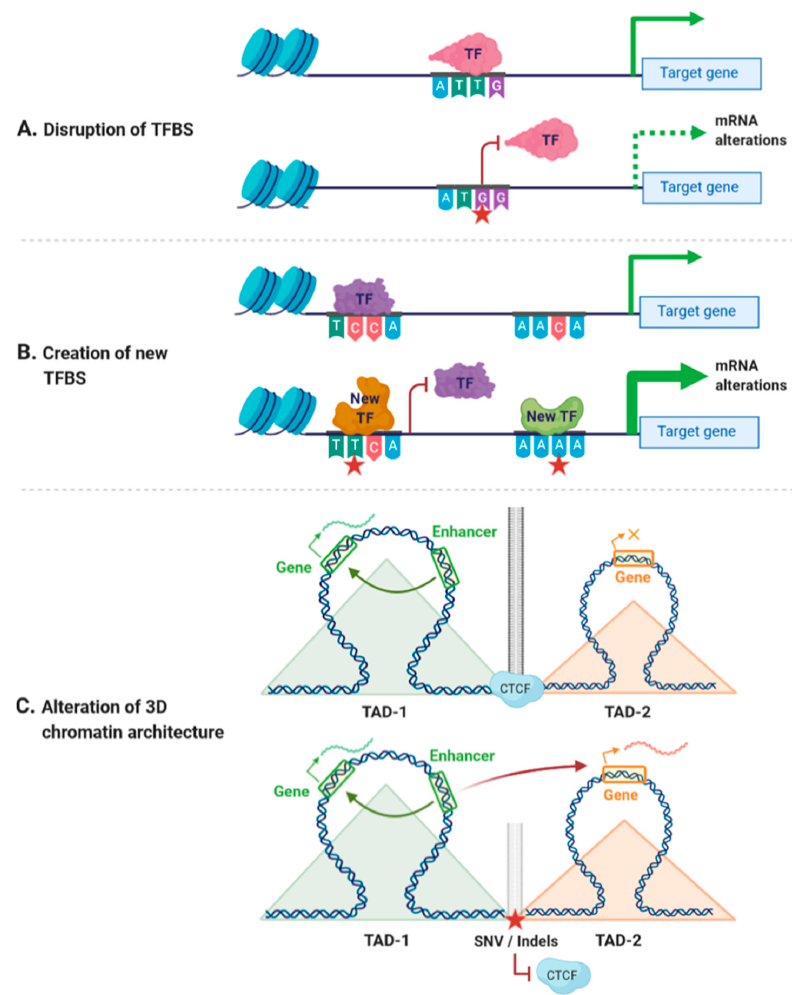
Figure 1. Effects of cis -regulatory variants. ( A ) Variants within cis -regulatory regions can disrupt transcription factor binding sites (TFBSs), leading to decreased mRNA expression. ( B ) Variants within cis -regulatory regions can create new TFBSs and generate new regulatory pathways. ( C ) Variants affecting the binding of CCCTC-binding factor (CTCF) can disrupt insulator activity between two topological associating domains (TADs), generating new enhancer–promoter interactions that may lead to altered expression of genes within these TADs. Red star indicates the position of a new single nucleotide variant (SNV) or an insertion/deletion (Indel). Orange × indicates inhibition of gene expression.